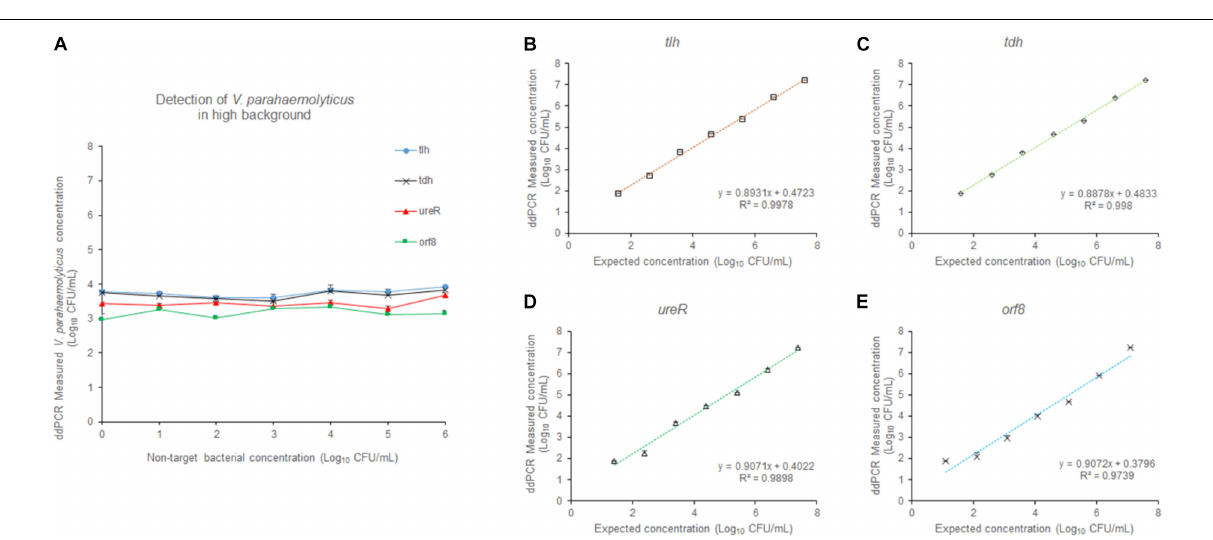
FIGURE 6 | The effect of the high concentration of non-target bacteria on the detection. (A) At different concentrations (10 1 –10 6 CFU/mL) of non-target bacteria, V. parahaemolyticus at the concentration of 10 3 CFU/mL was detected. At the concentration (10 6 CFU/mL) of non-target bacteria, V. parahaemolyticus samples containing tlh (B) , tdh (C) , ureR (D) , and orf8 (E) at different concentrations (10 1 –10 7 CFU/mL) were detected. Plotted values represented the means of 3 independent